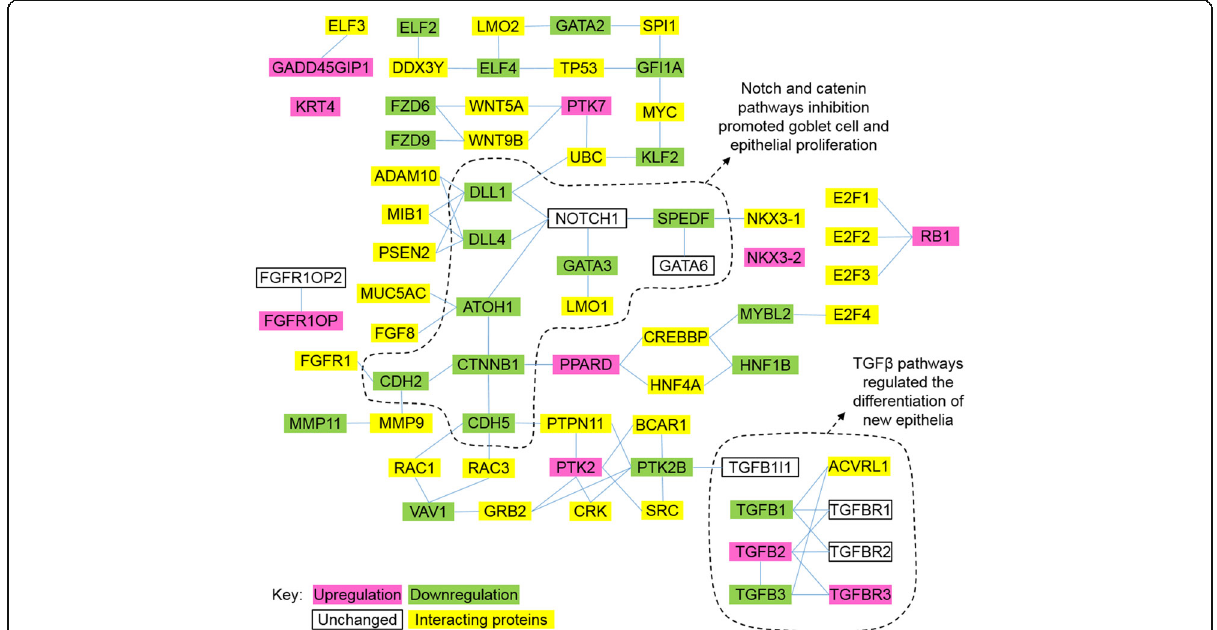
Fig. 9 Protein interaction networks of the epithelial growth factors in posterior intestine listed in Additional file 1: Table S1 by STRING analysis. Constitutive and regulatory factors were combined to show the dynamic changes of mucus cells in early SW transfer. Downregulation of notch and β -catenin pathways promoted mucus cell activities, desquamation of epithelial cells, and rapid remodeling of the intestine